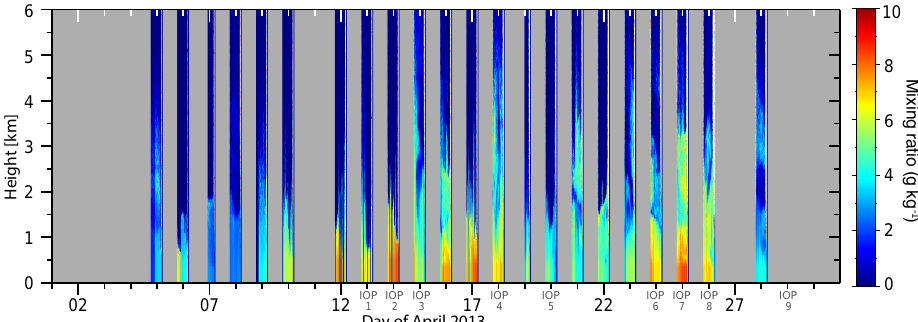
Figure 9. Calibrated night-time observations at KRA of the water vapour mixing ratio for April 2013 during HOPE-Jülich obtained from Polly XT that were calibrated automatically with the integrated water vapour provided by a co-located microwave radiometer. Adapted from Foth et al.